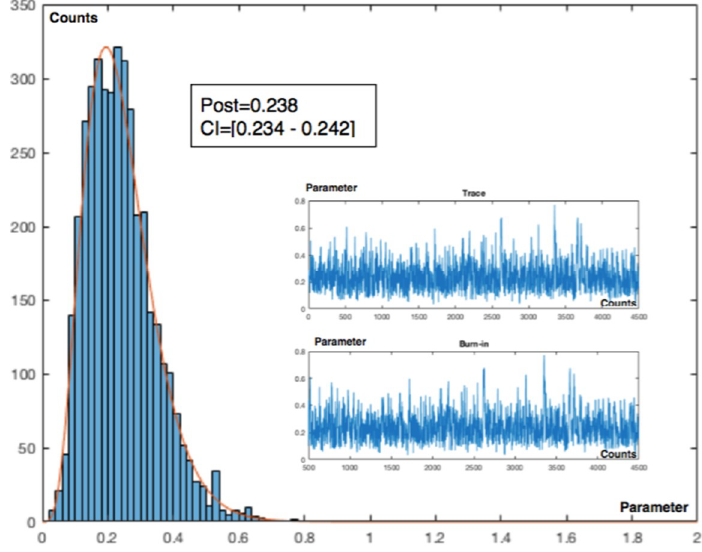
Figure 20. Metropolis–Hastings. Interval 8. Sampling n = 4500, burn = 500; 10 cycles. AR = 63%.